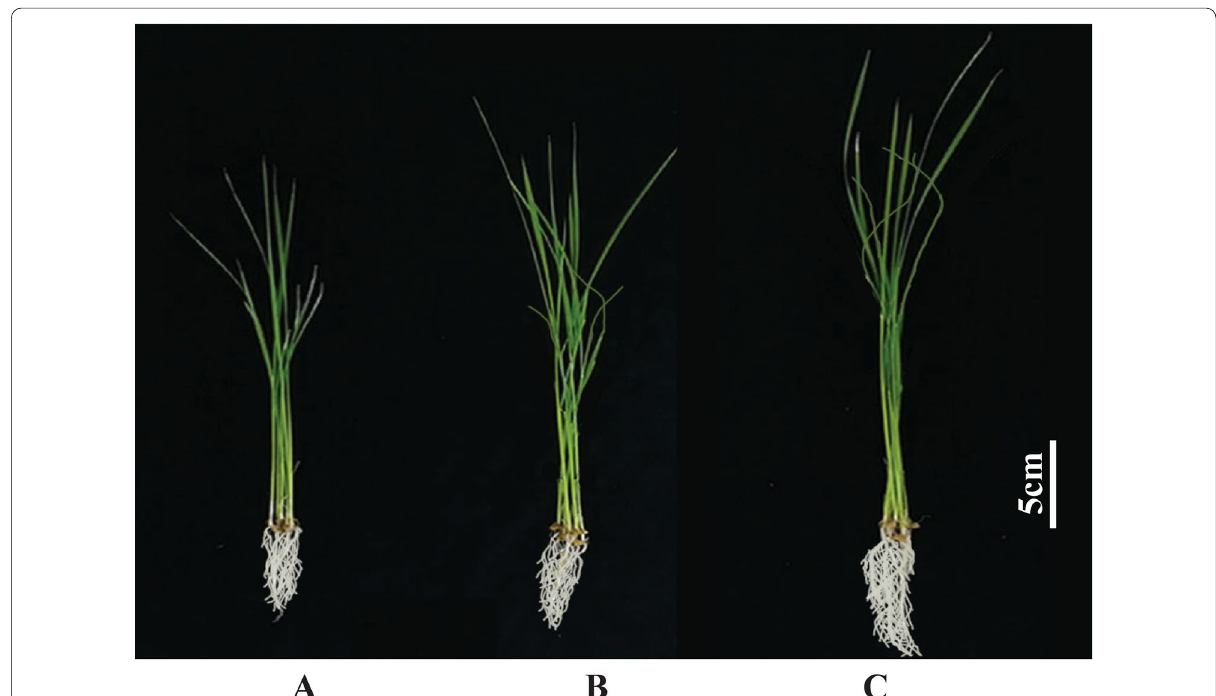
Fig. 2 Effects of inoculating with PGPE bacteria on the growth of shoots and roots in rice seedlings after treatment for 15 days. A Control (non-inoculated), B Rice seedlings inoculated with strain ND06, C Rice seedlings inoculated with strain